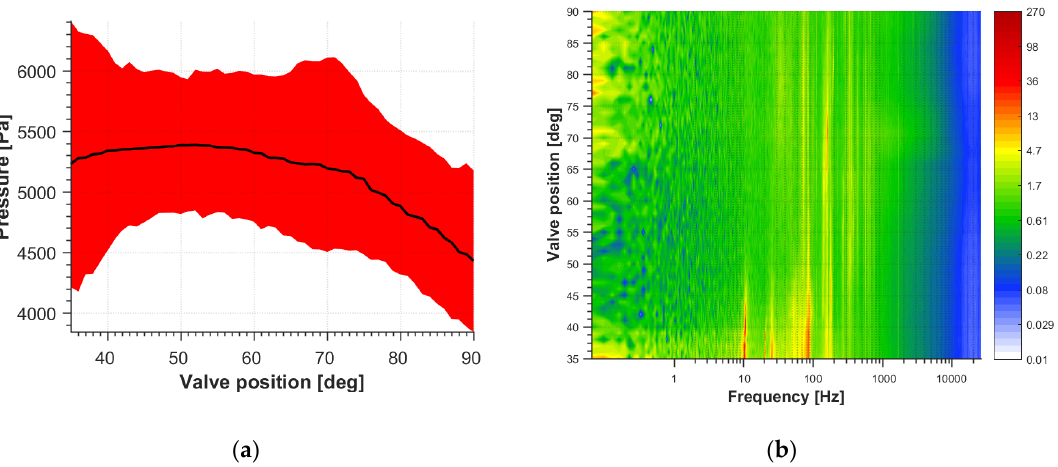
Figure 10. Pressure variation depending on the valve position measured at the diffuser at impeller rotational speed 110 Hz. ( a ) The left plot represents the min-to-max plot (red) and the pressure average value (black). ( b ) The right plot represents the spectral map with the colormap in the logarithmic